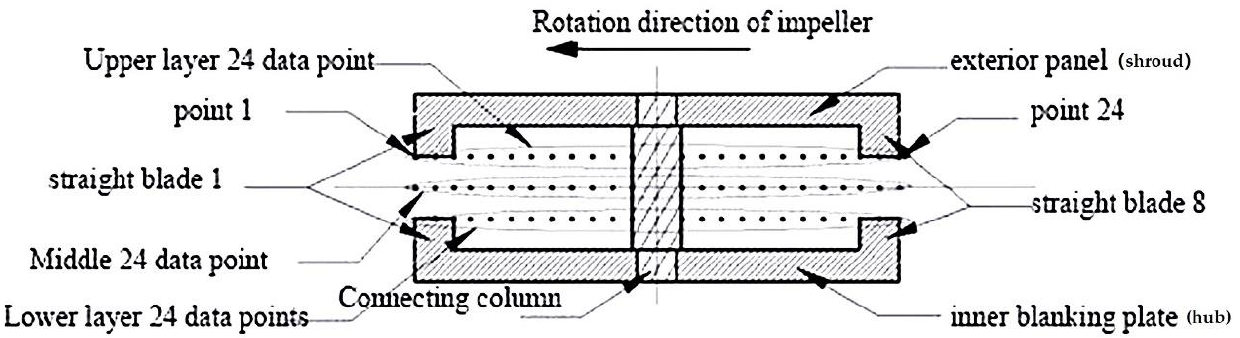
Figure 19. Definition of the position of the axial measuring point inside the impeller.